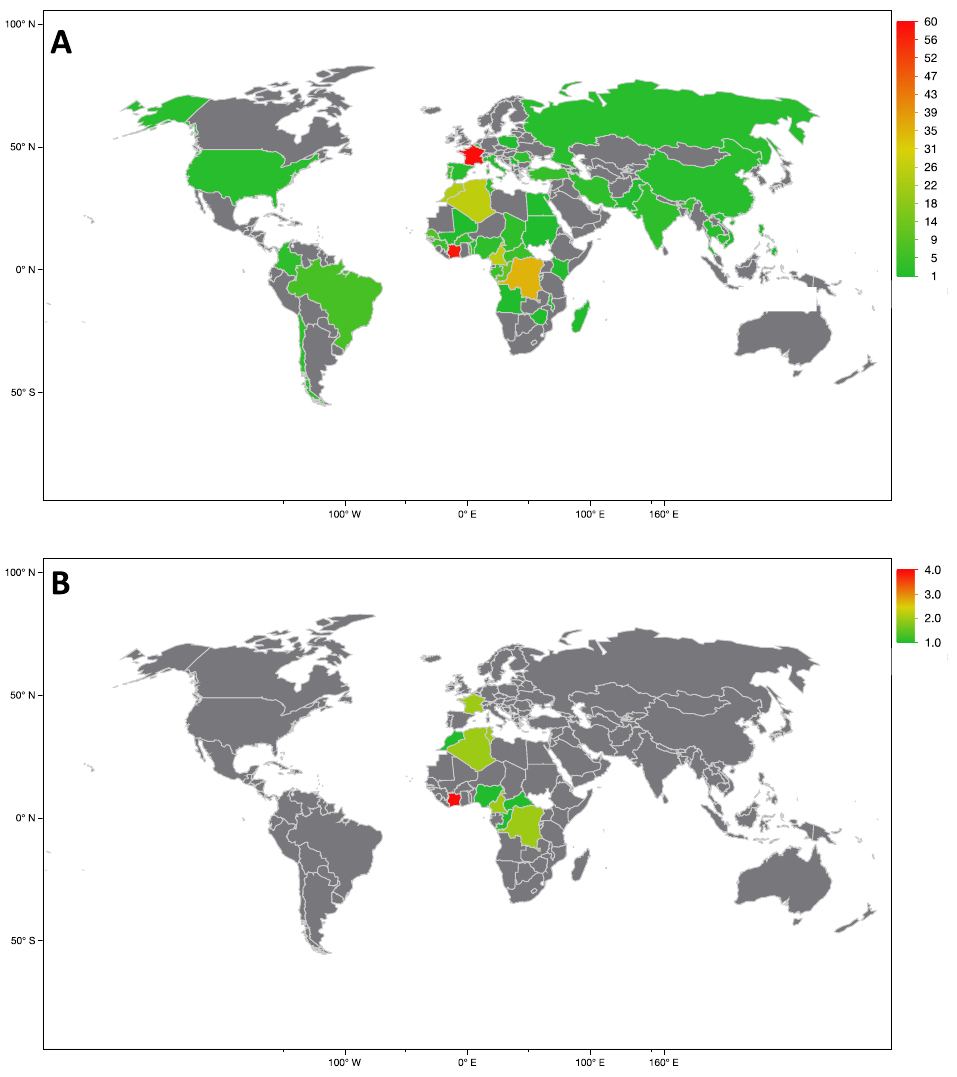
Figure 1. Cartography maps of the recruitment of our hospital of HIV patients according to persistent follow-up ( A ) and loss of follow-up ( B ).